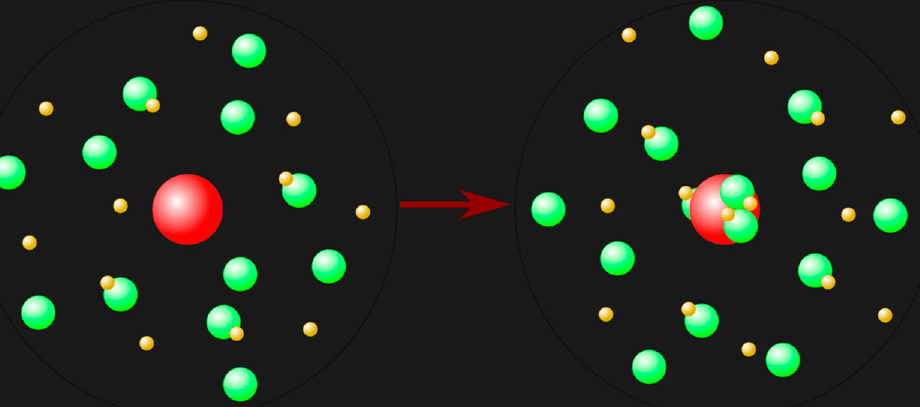
Figure 6. The proposed scheme of calcium sulfate nucleation by nanodust particles (red spheres); green spheres correspond to sulfate ions, yellow spheres – to calcium cations.